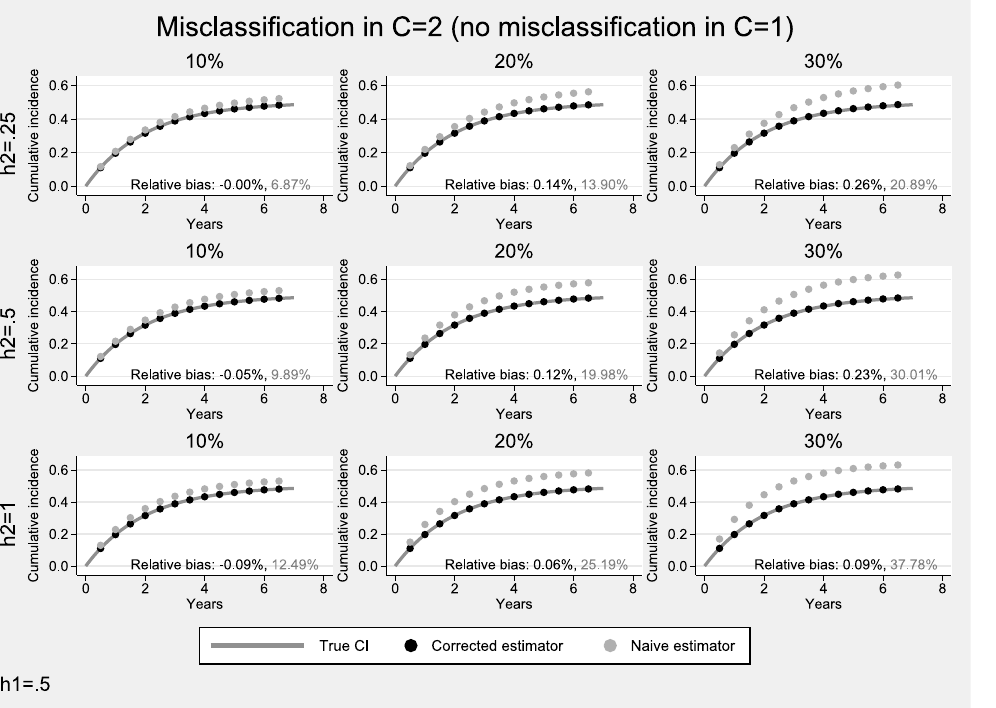
Fig 1. Simulation results for the case of unidirectional misclassification: Only the competing endpoint was subjected to misclassification. The hazard for the primary endpoint was assumed to be moderate ( h 1 = 0.5). Solid lines correspond to the true cumulative incidence whereas dotted lines to the estimates from the non-parametric Aalen-Johansen estimator for the primary